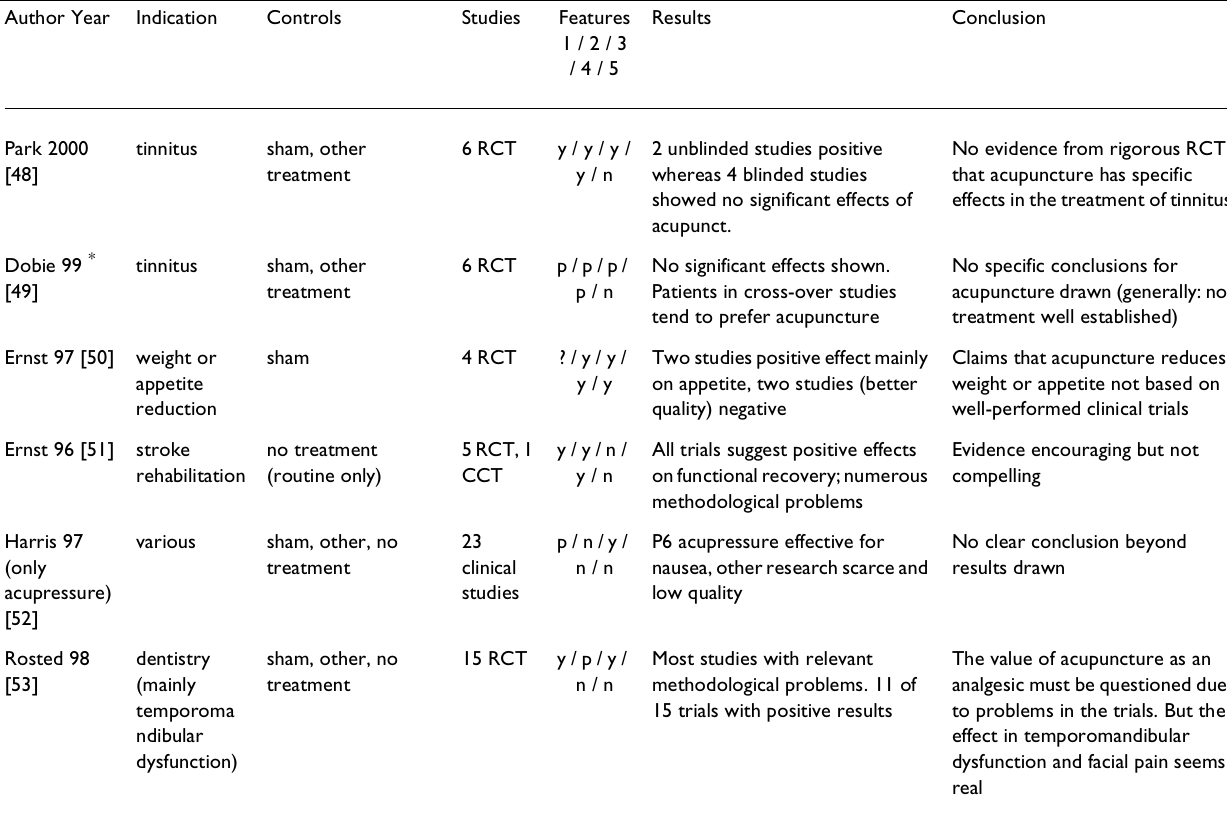
Table 3: Systematic reviews of clinical trials of acupuncture & acupressure in various conditions Author